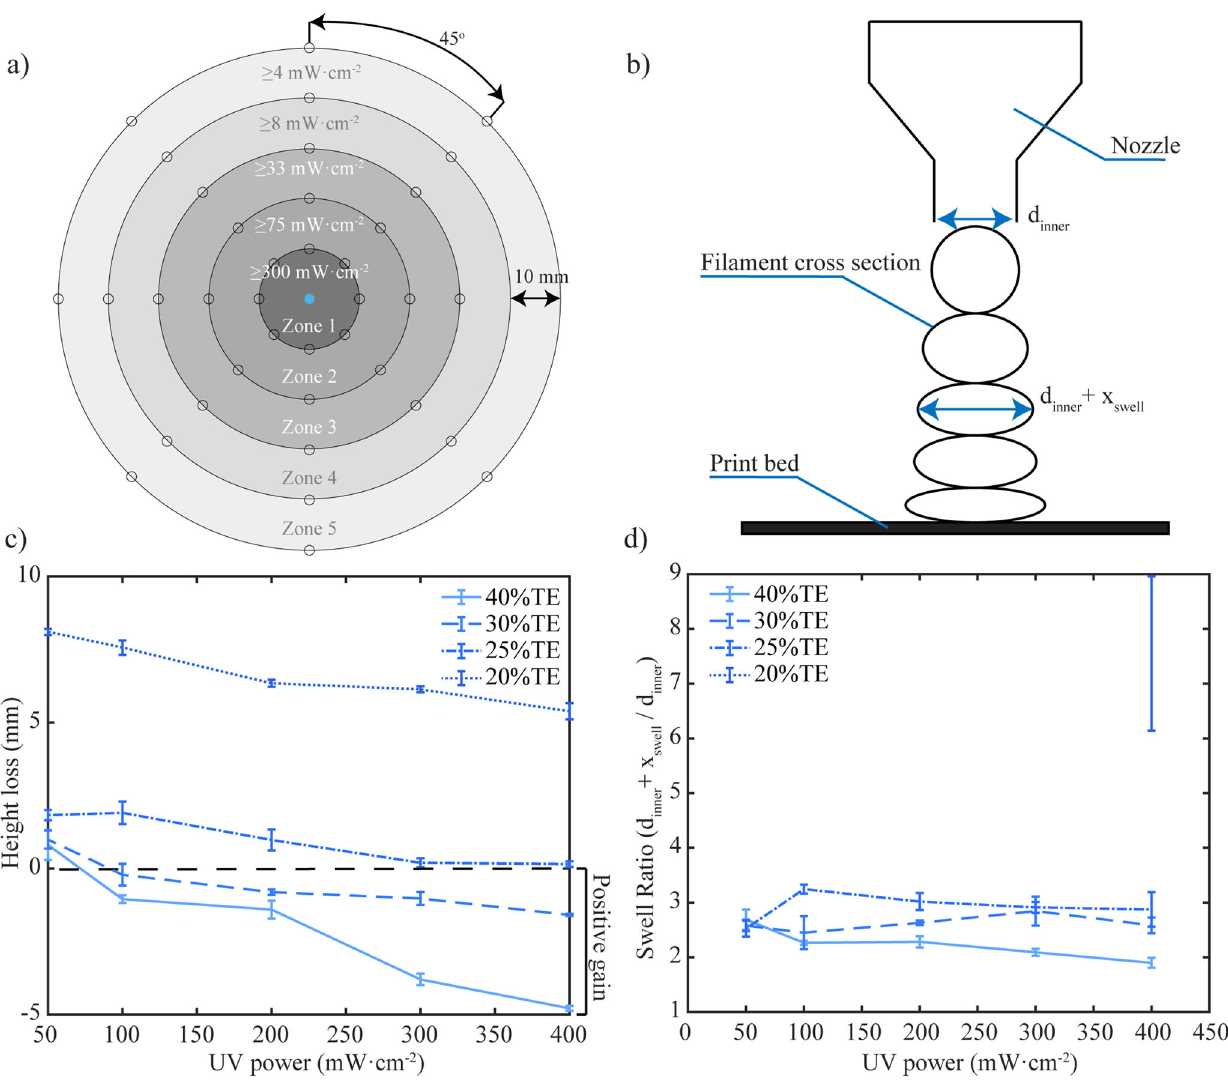
Fig. 4 Relationships between height loss, swell ratio, thiol-ene content, and UV power. a UV power mapping divided into zones around the extruder head. The blue dot indicates the center of the nozzle. b Schematic illustration of swell ratio due to accumulated upper layer weight and normal stress change of the material during curing. c Height losses measured based on changes in thiol-ene weight fraction and UV power. (Computer-designed height 10 mm, see Supplementary Fig. 7). d Effects of UV power and thiol-ene weight fraction on fi lament swell ratio at the top locations of the printed objects. Swell ratios measured at the basal sections can be seen at Supplementary Fig. 7. Error bars represent one standard stress – strain curves (Fig. 6a). For 3D printed dumbbell samples, we used three print directions: vertical, horizontal and cross